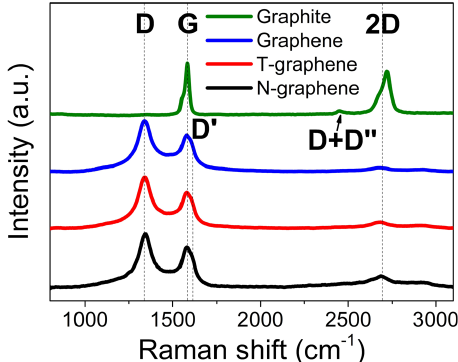
Figure 2. Raman spectra of the electrocatalysts and of graphite.